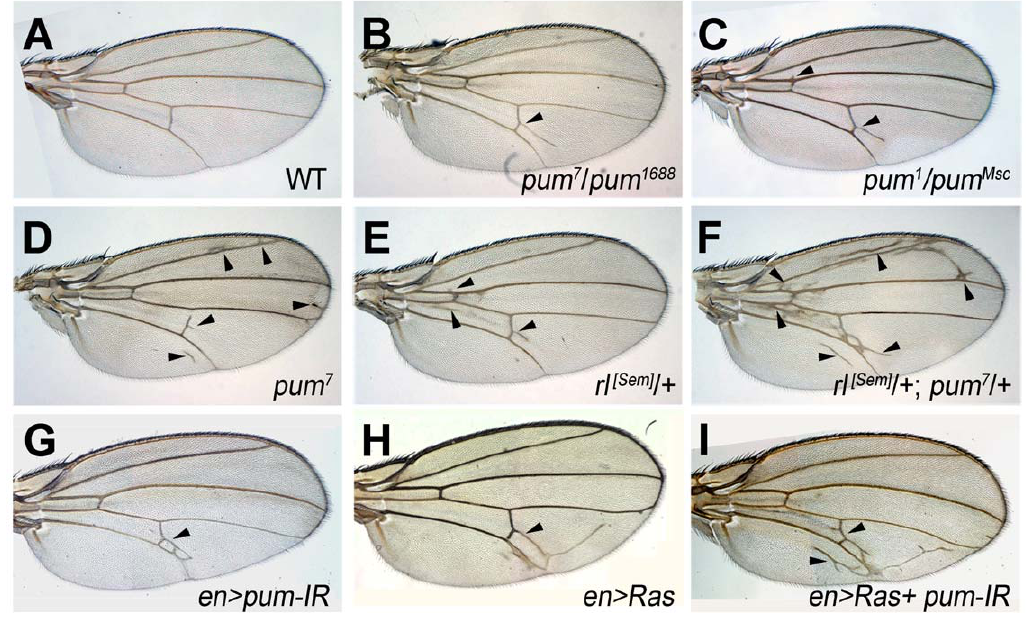
Figure 1. Genetic interaction between Pum and EGFR signaling in wing vein development. Wild-type wing displays five wing veins (A). Extra wing veins indicated by arrowheads arose in pum mutants, pum 7 / pum 1688 (B), pum 1 / pum Msc (C), and pum 7 / pum 7 (D). Extra wing veins arose in a gain of function mutant of rl ( rl [Sem] / + ) (arrowhead, E). pum dominantly increased wing veins induced by enhanced rl signaling ( rl [Sem] / + ; pum 7 / + ) (F). Extra wing veins also arose in the posterior region where pum is downregulated by RNA interference ( en-Gal4 / + ; UAS - Pum-IR/ + ) (G) or Ras is over- expressed (H). RNAi reduction of pum with enhanced Ras expression greatly increased wing veins ( en-gal4 / UAS-Ras ; UAS-Pum-IR / + ) (I).